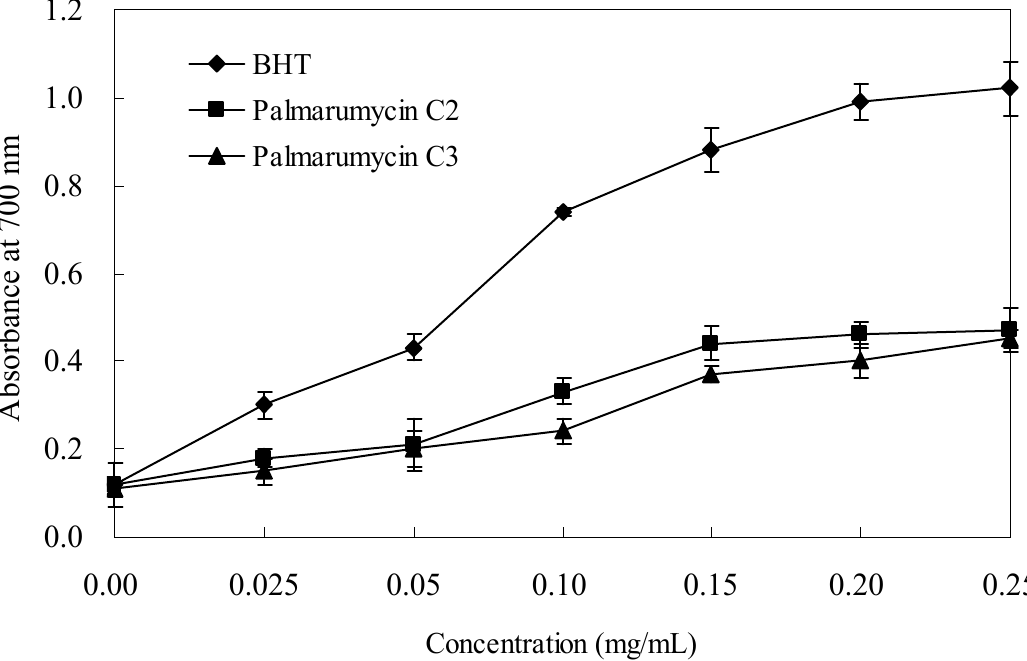
Figure 3. Reducing power of palmarumycins C as a mean ± SD ( n =